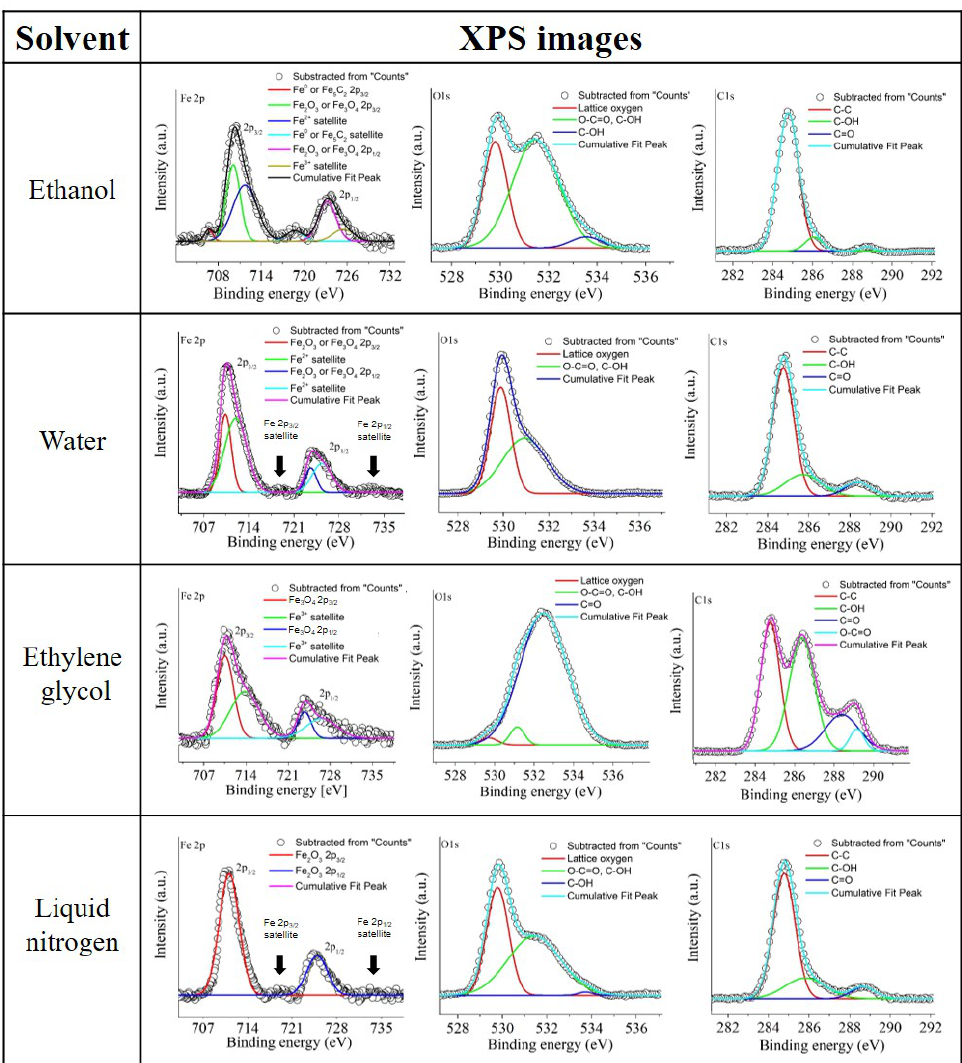
Figure 4. List of XPS spectra for the supernatant of each sample. The binding energies were corrected, taking the C–C peak of each sample as a